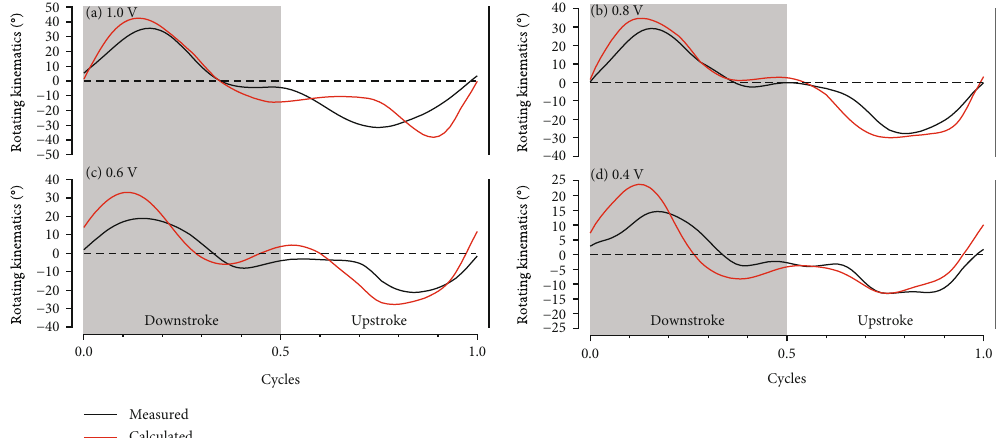
Figure 12: The measured and calculated rotating kinematics of the arti fi cial wing under the input voltage amplitudes of (a) 1.0V, (b) 0.8V, (c) 0.6V, and (d)